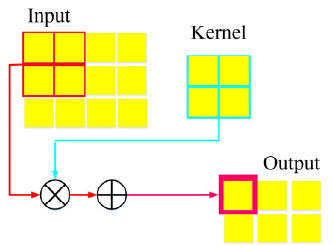
Figure 1. Schematic diagram of 2D convolution operation.